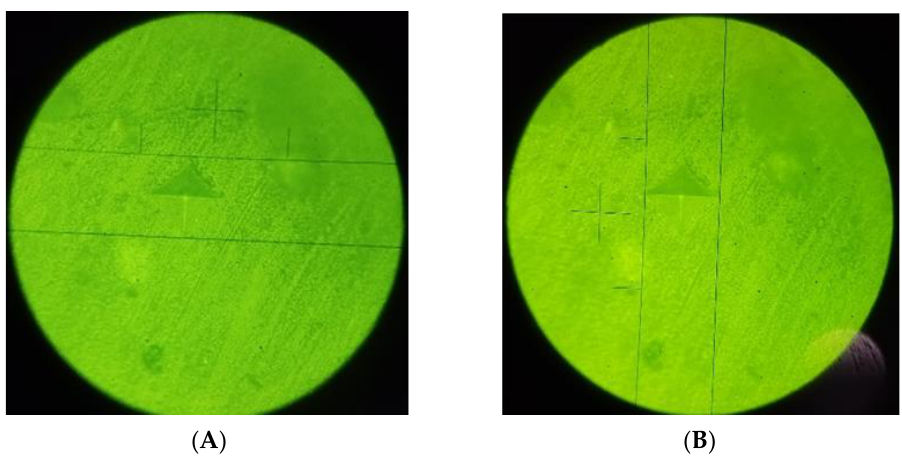
Figure 6. ( A ) Filtek Bulk Fill without OIL control; ( B ) Filtek Bulk Fill with OIL